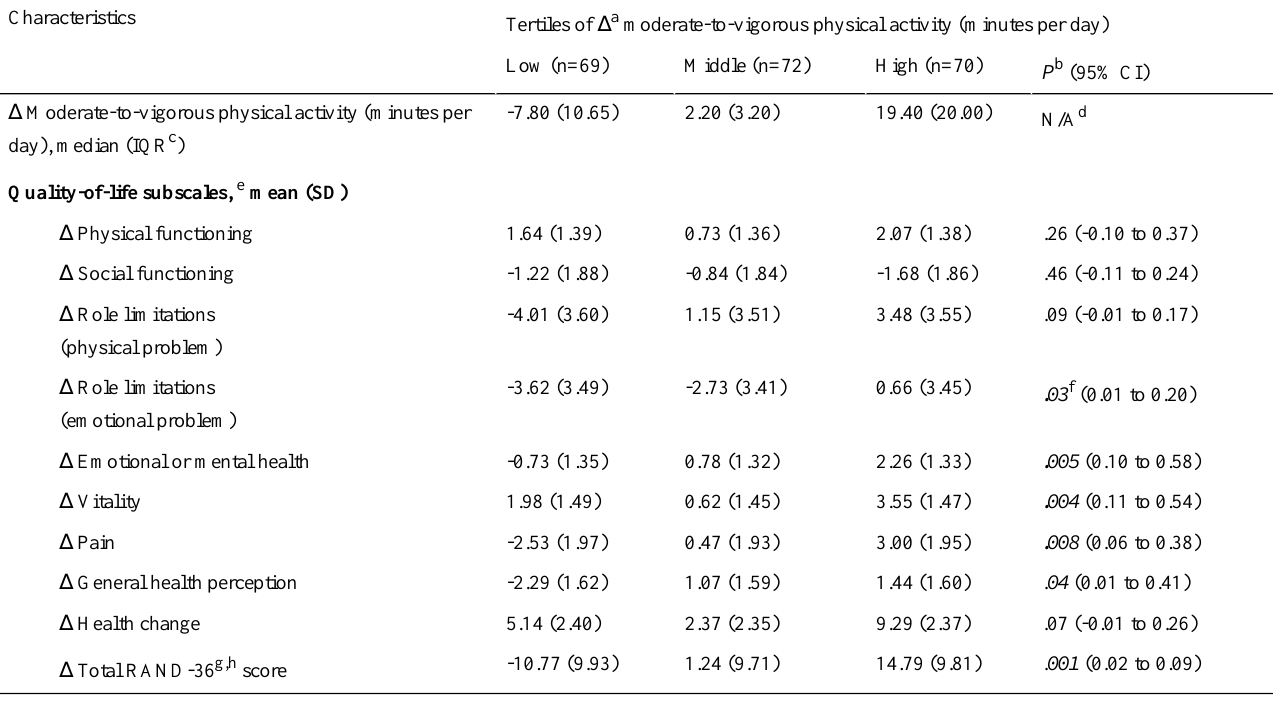
Table 3. Dose-response relationship of the change in minutes spent in moderate-to-vigorous physical activity with quality of life. Tertiles of Δ a moderate-to-vigorous physical activity (minutes per